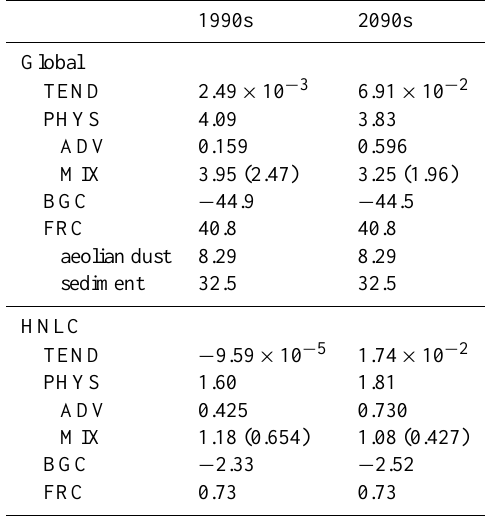
Table 2. Globally integrated dissolved iron budget in the upper 100m (Gmolyr − 1 ) .